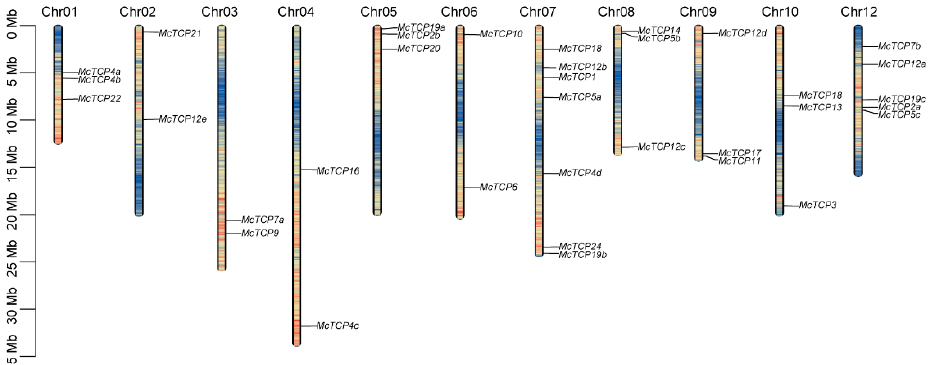
Figure 1. Gene location in different chromosomes. Length of the bars represents the size of the chromosome. Different color within each bar represents gene density on the chromosome. Red means high gene density, and blue means low gene density.